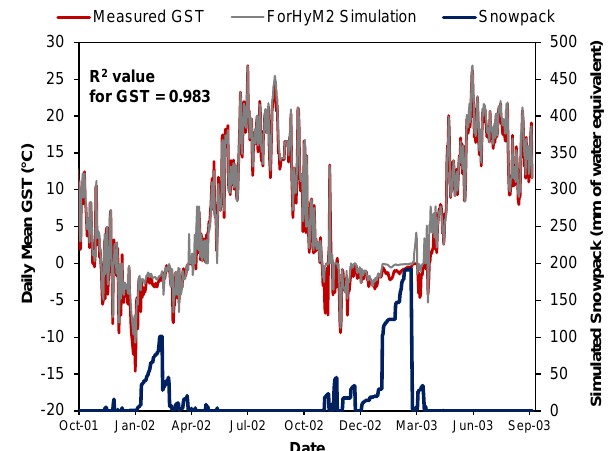
Fig. 4. Measured and ForHyM2-simulated GST and ForHyM2- simulated snowpack for the Catamaran Brook catchment for the Oc- tober 2001–September 2003 period. Measured and simulated GST data are relatively constant during the snow-covered